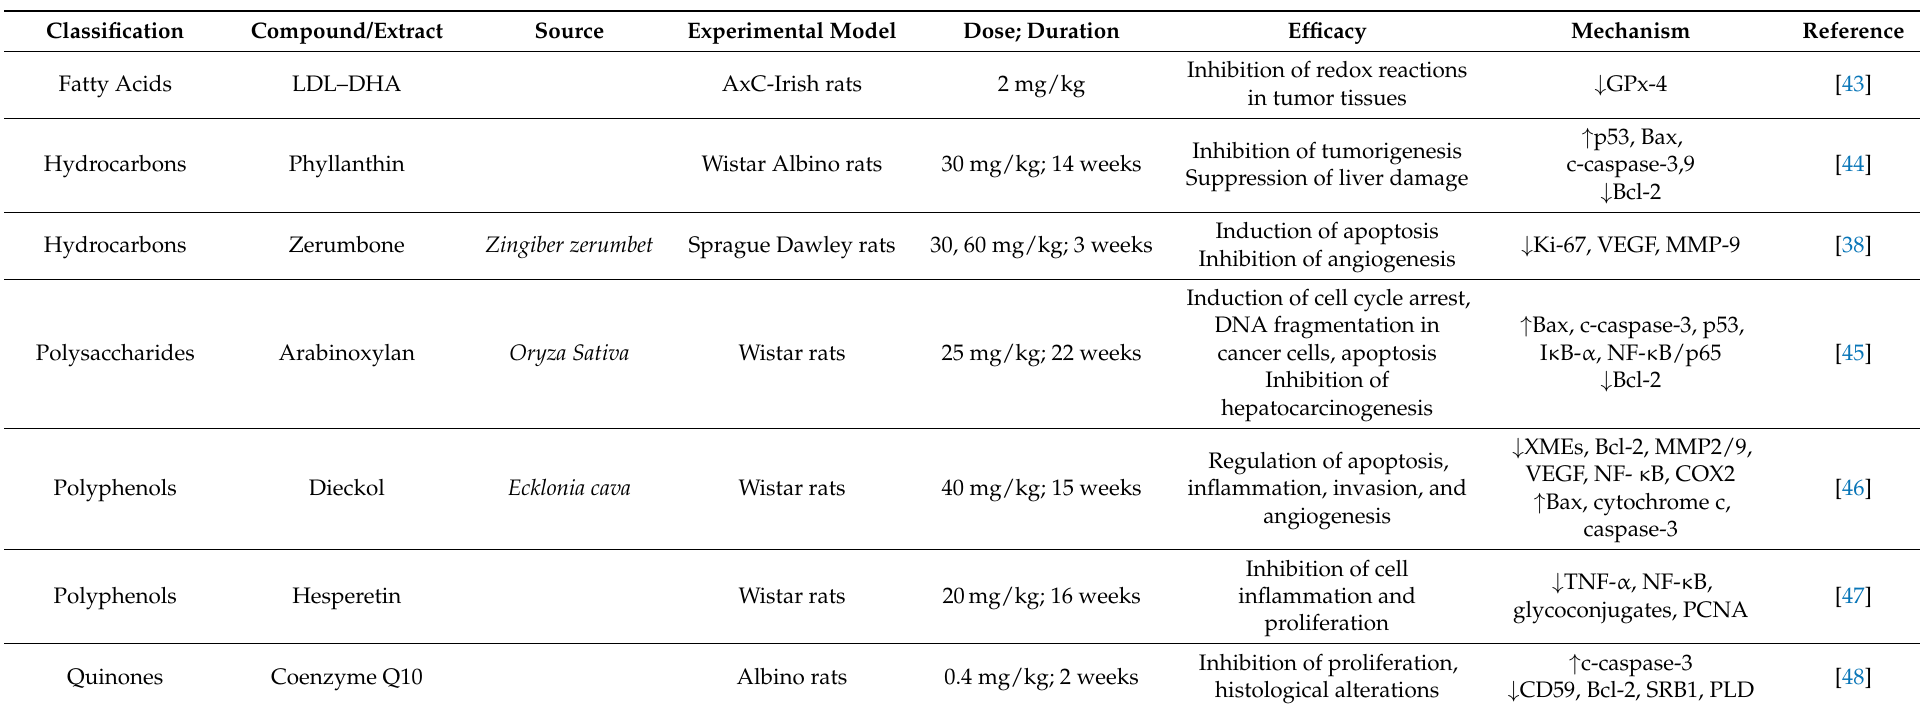
Table 4. In vivo rats—single